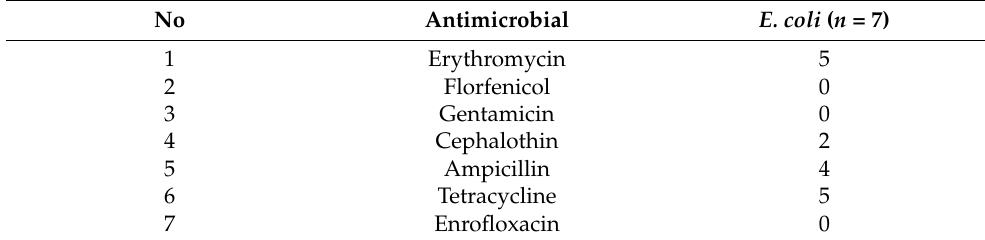
Table 4. Antimicrobial drug resistance profile of the isolated E. coli strains.